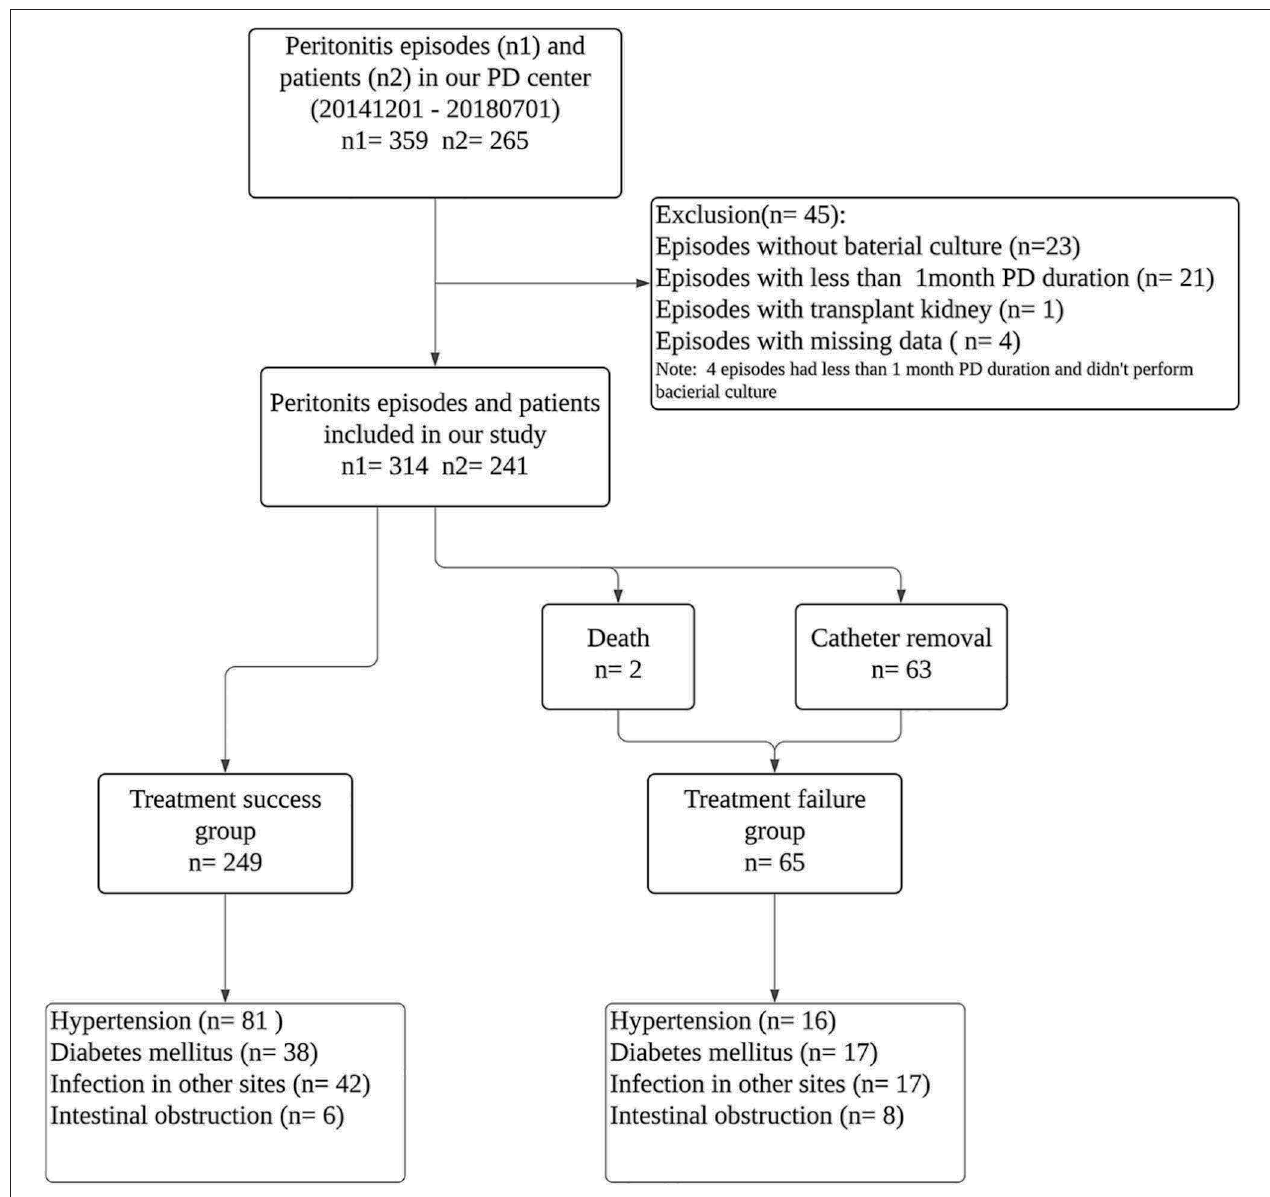
FIGURE 1 | Flow chart for the study participants enrollment and